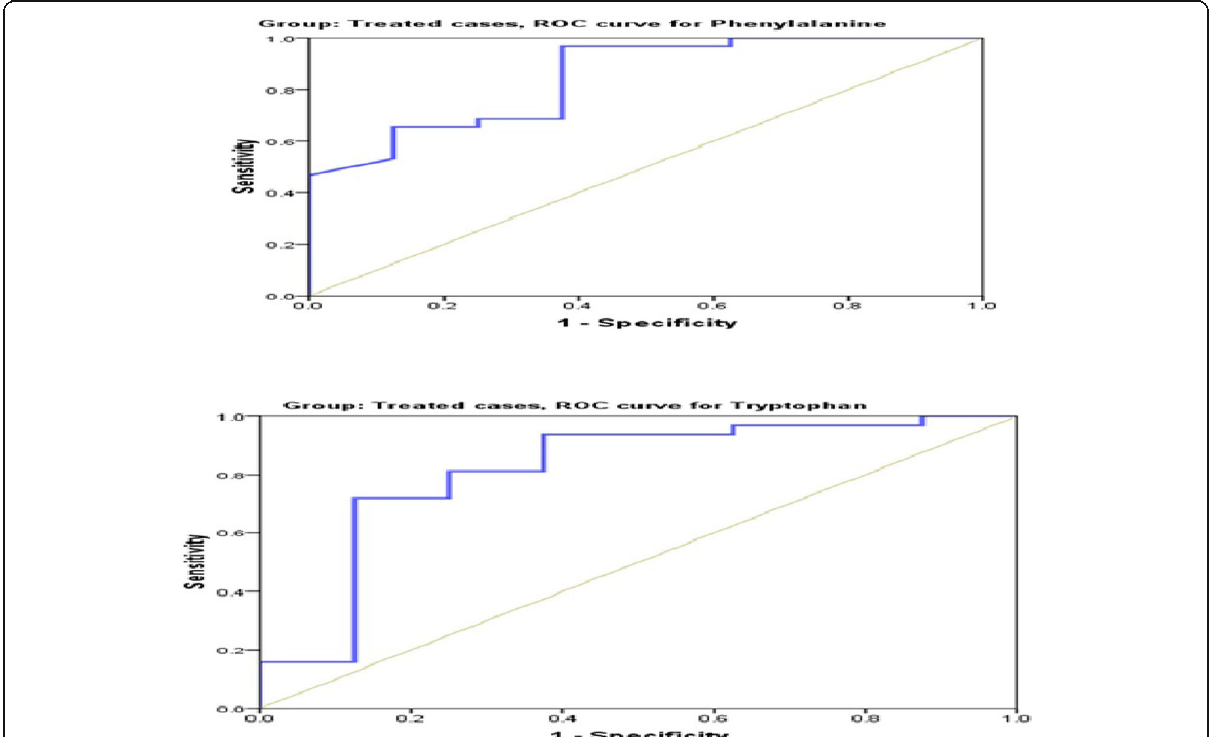
Fig. 1 Scatter graph showing a positive correlation between phenylalanine level and HDRS and b negative correlation between tryptophan level and